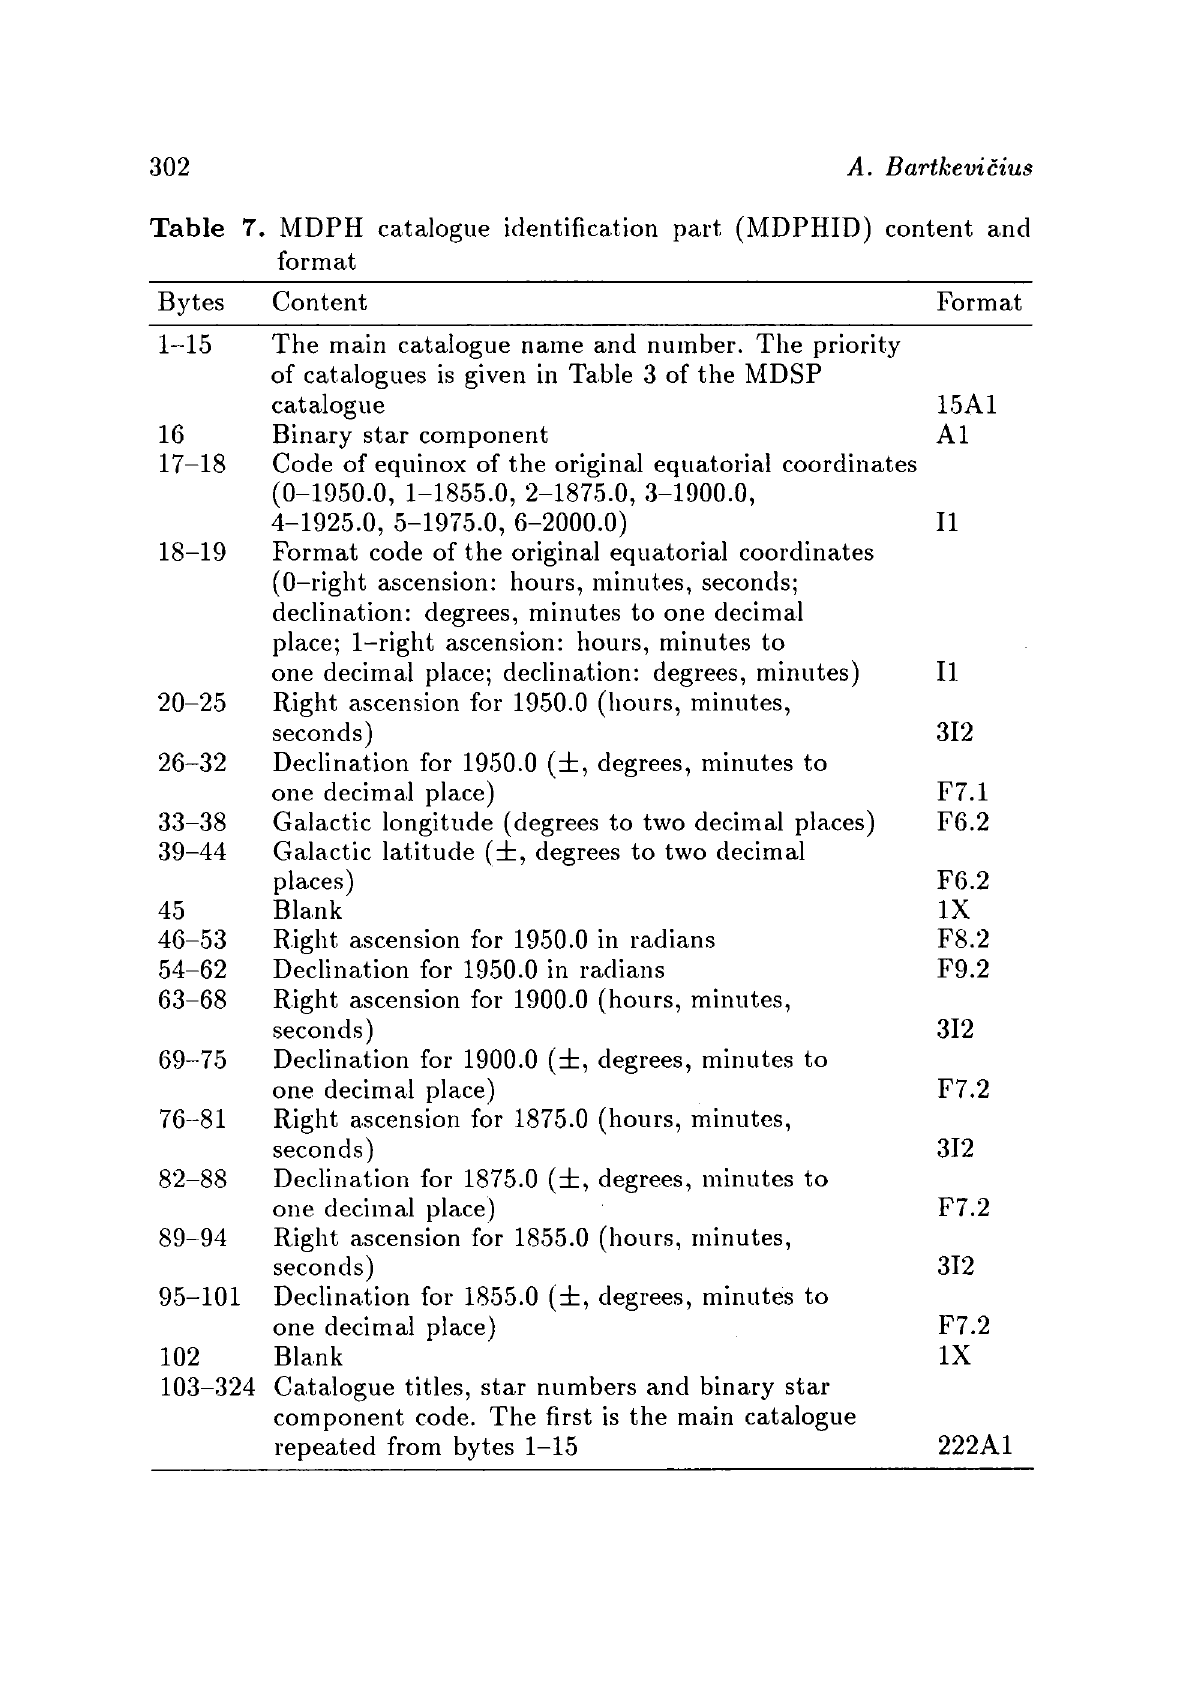
Table 7. MDPH catalogue identification part (MDPHID) content